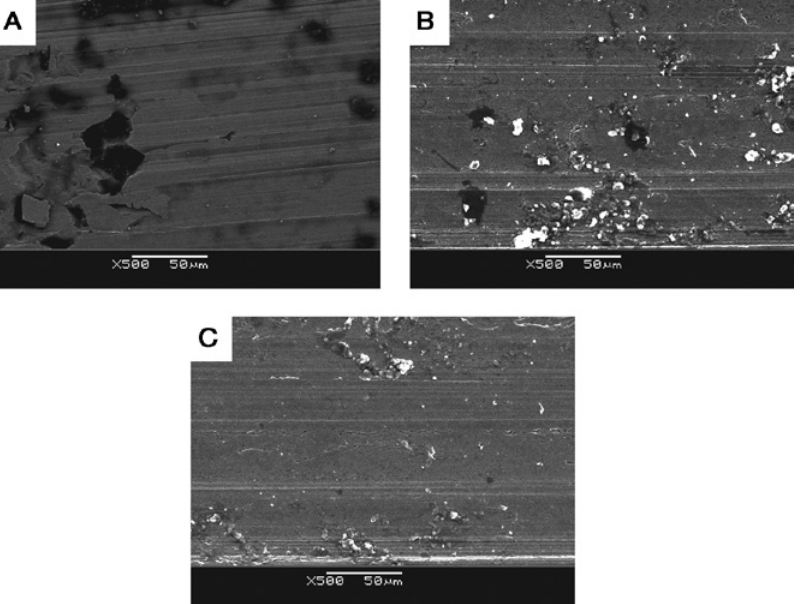
Figure 9: Scanning electron microscopy (SEM) micrographs of the worn surface of Ni-TiN composite coatings deposited with different mag- netic intensities: (A) 0 T, (B) 0.3 T and (C) 0.6